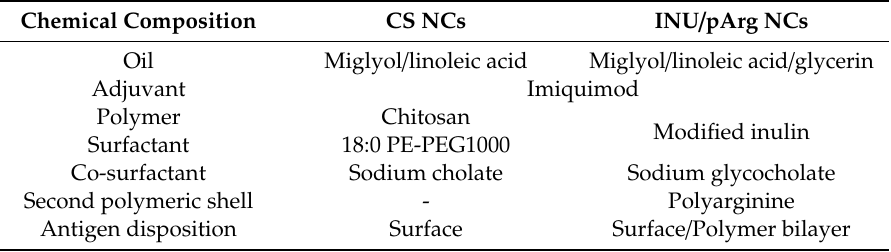
Figure 1. Polymeric vaccine prototypes designed for the development of an intranasal vaccine against the Mycobacterium tuberculosis fusion protein ESAT-6 / CFP-10 (ECH protein). In the oily core, Imiquimod, a TLR-7 agonist, was added as adjuvant to increase the immunogenicity of the fusion Table 1. Chemical composition of the CS and INU / pArg nanocapsules (NCs) developed in this work. CS: Chitosan, INU: Inulin, pArg: Polyarginine.